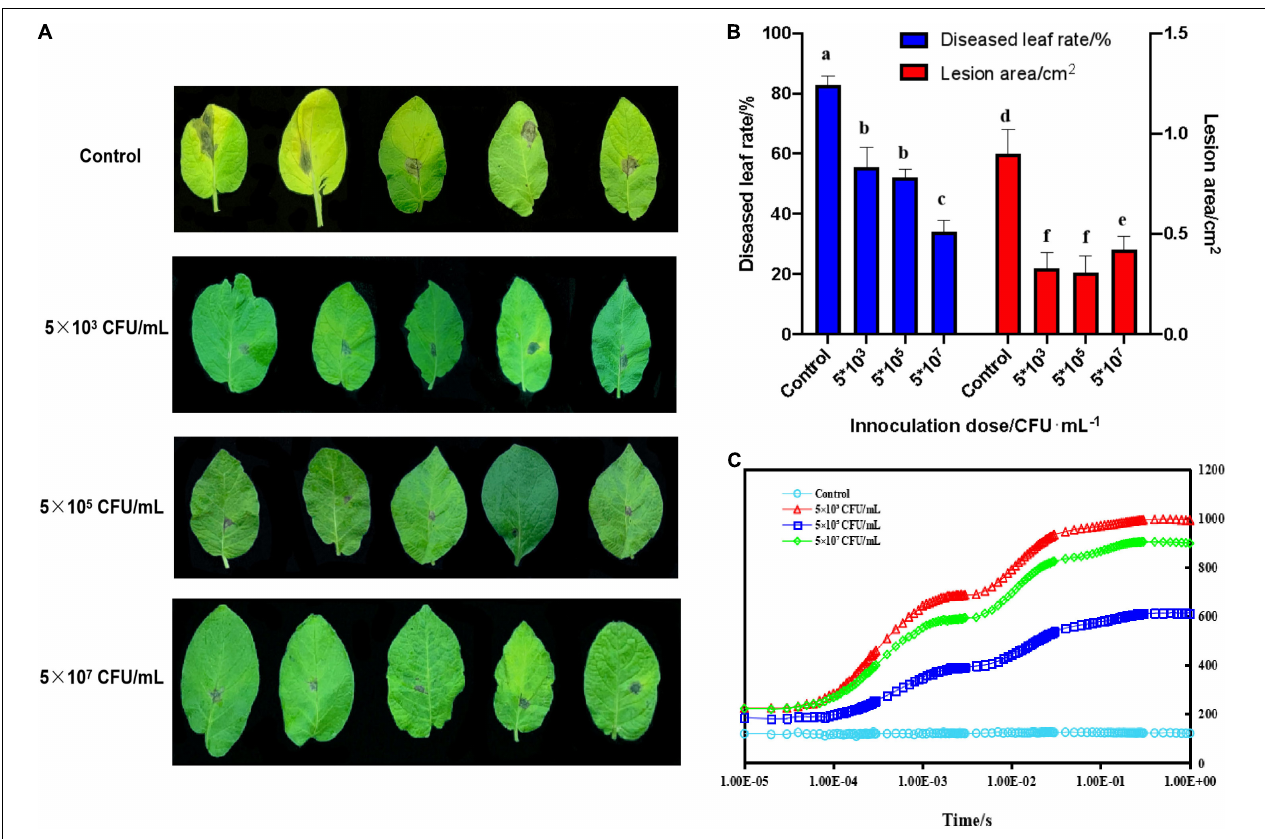
FIGURE 1 | Biocontrol effects of B. subtilis ZD01 fermentation broth on the potato early blight in a pot assay under greenhouse conditions. (A) Effects of 5 × 10 3 , 5 × 10 5 , and 5 × 10 7 CFU/mL of B. subtilis ZD01 fermentation broth on the development of early blight symptoms of potato leaves. (B) The diseased leaf rate and lesion areas of potato leaves inoculated with A. solani HWC-168 with or without the ZD01 fermentation broth treatment. (C) Chlorophyll α fluorescence induction of a diseased potato leaf (kept in darkness for 20 min before the measurement). Data are presented as means of three replicates ± SDs, and error bars represent the SDs for three replicates. Means with different letters have significant differences ( p <